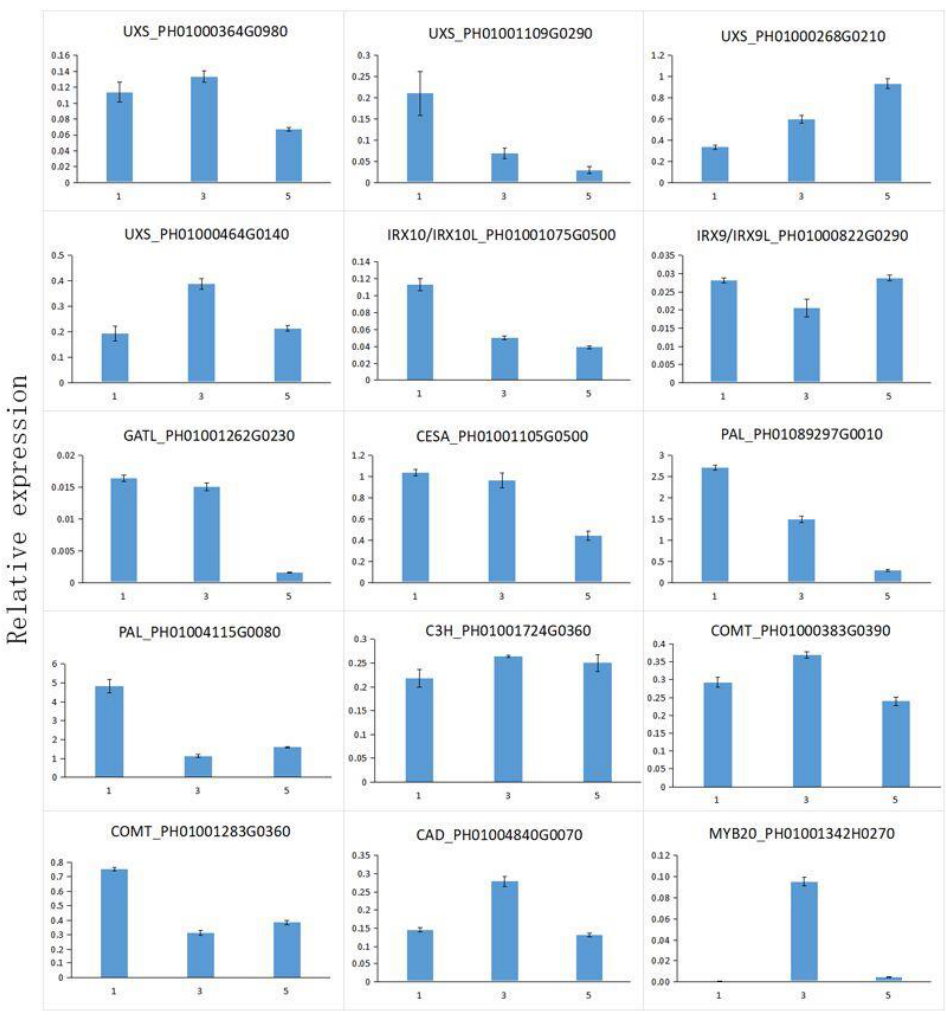
Figure 9. The expression profiles of the selected genes in MBSes during cold storage. The transcript levels were normalized to those of the nucleotide tract-binding protein (NTB), and the level of each gene in the control was set at 1.0. Each data represent the means ± SD ( n = 3).